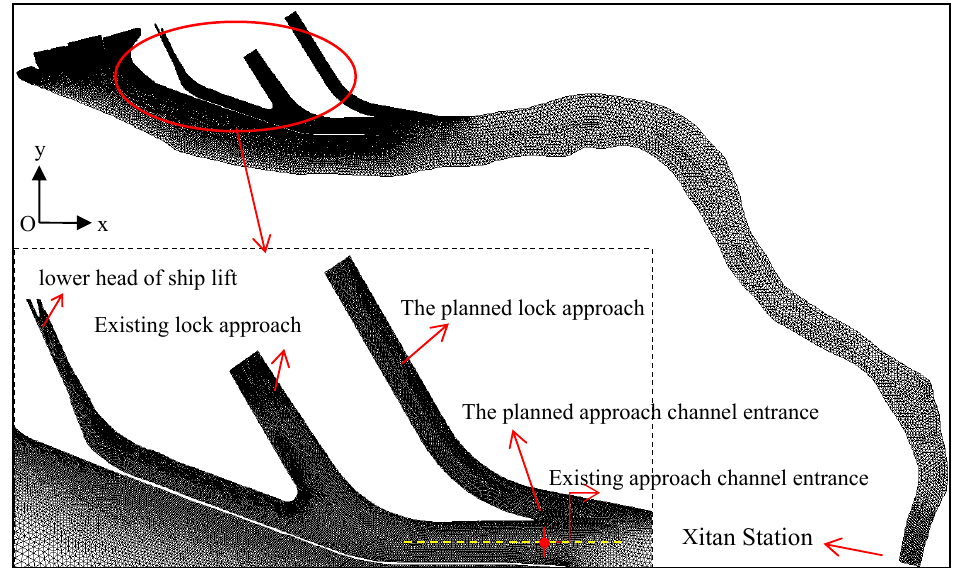
Figure 4. Computation domain and mesh generation.